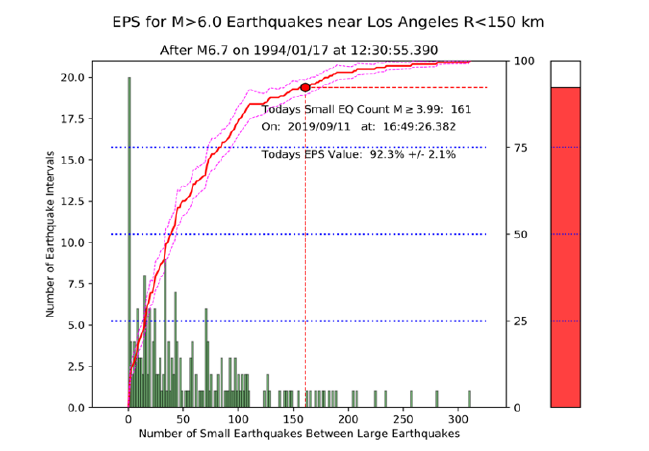
Figure 2. Example of a nowcast for M6 earthquakes near Los